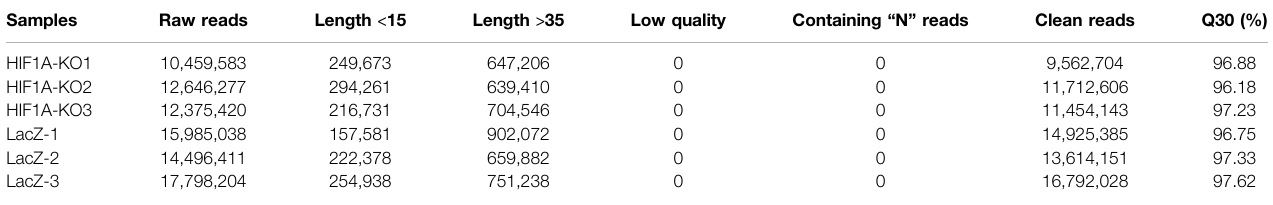
TABLE 5 | Summary of sequence data generated of small RNA and quality fi ltering.